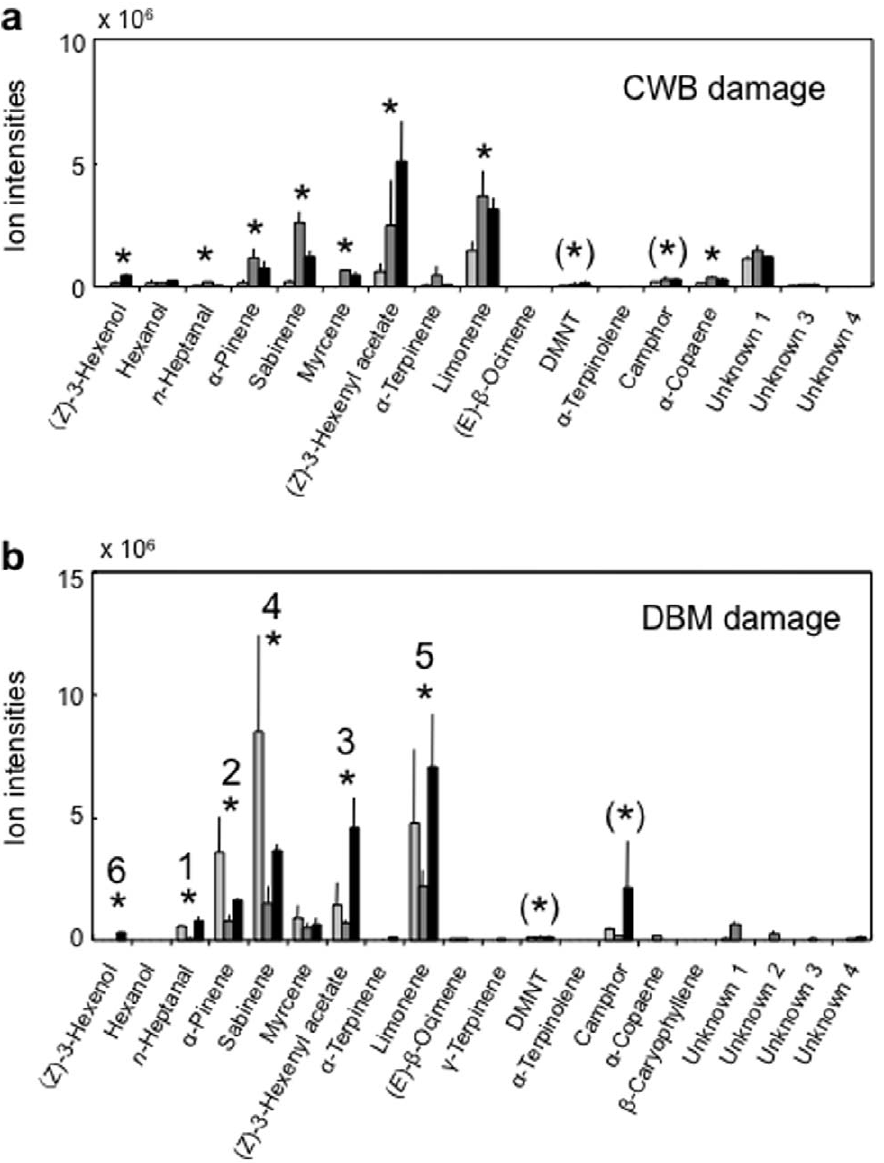
Figure 3. GC-MS analysis of headspace volatiles from herbivore-damaged cabbage ( B.oleraceavarcapitata cv Shikidori). Plants had either 5, 15 or 30% damage by CWB larvae (3a) or by DBM larvae (3b). For each compound ( x -axis), mean ion intensities ( y -axis), plus standard error (vertical bars), are shown for emission from plants without damage (white column) and with either of three damage levels (in order of increasing damage: greyish, grey and black columns). DBM-induced volatiles are highlighted by superposed rank numbers according to significance level from Student’s t -tests (these ranks serve as reference in Figure 4ab and 5).